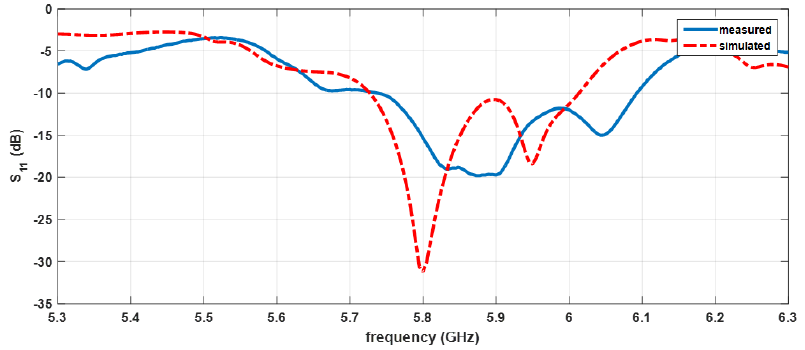
Figure 11. Simulated and measured reflection coefficient (S 11 ) of the antenna.